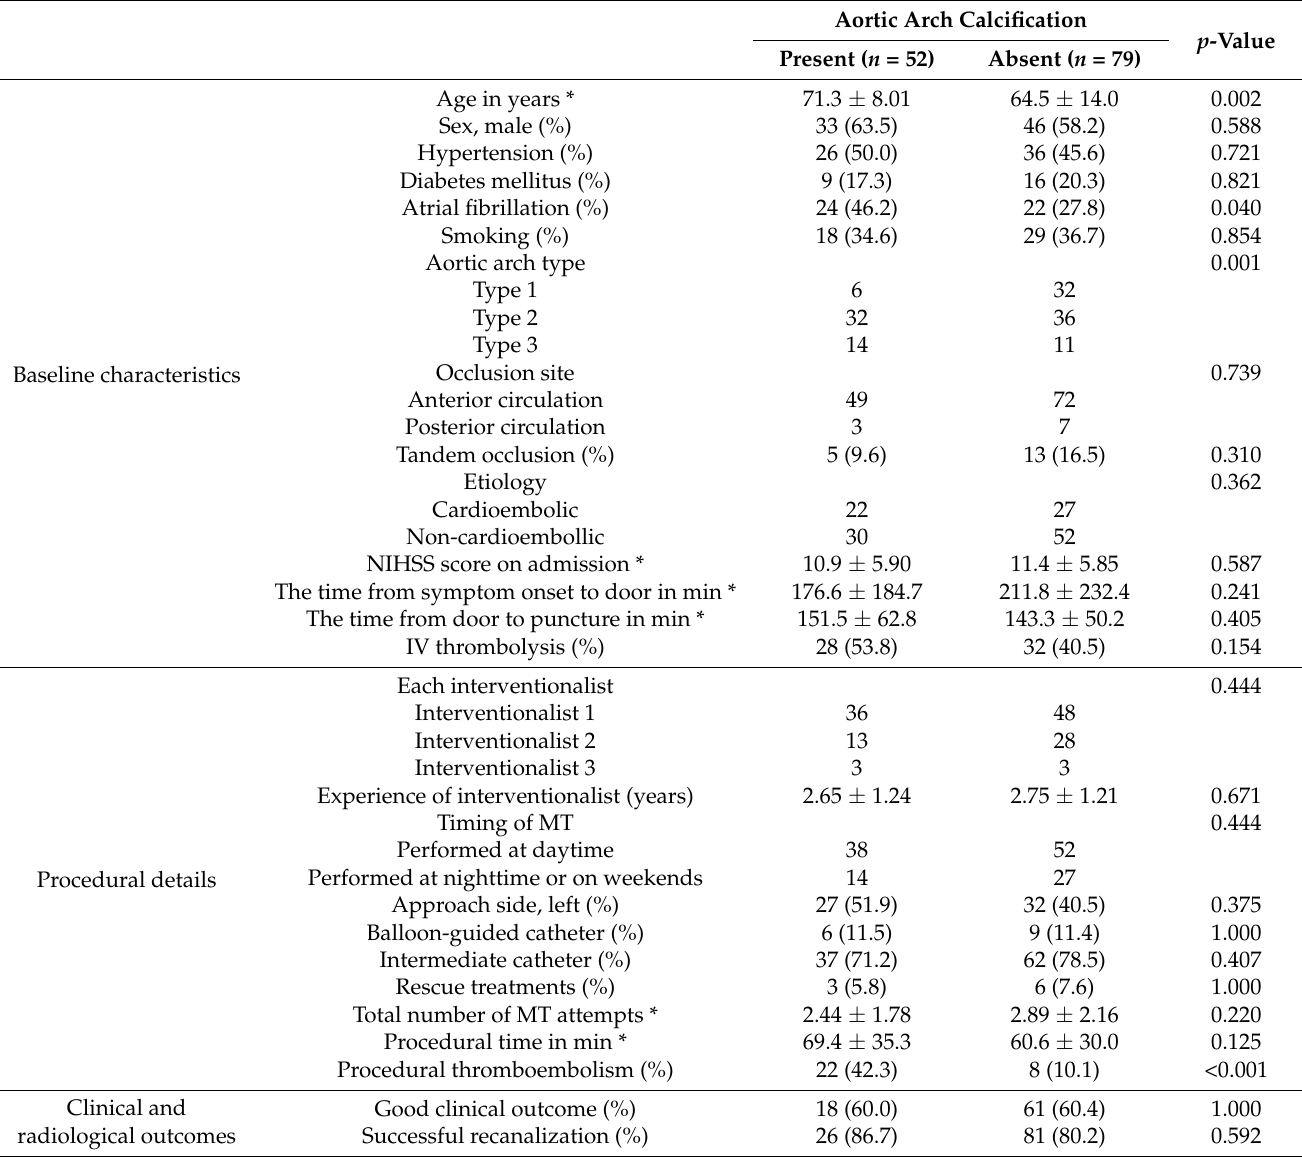
Table 1. A comparison of patients with and without aortic arch calcification on chest X-ray before mechanical thrombectomy for acute ischemic